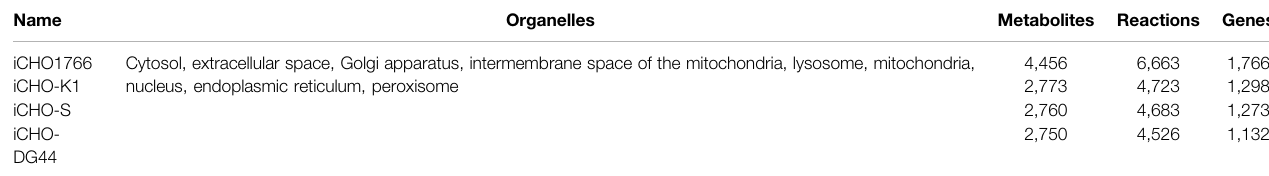
TABLE 2 | Cell-line-speci fi c genome-scale metabolic models (Hefzi et al., 2016).